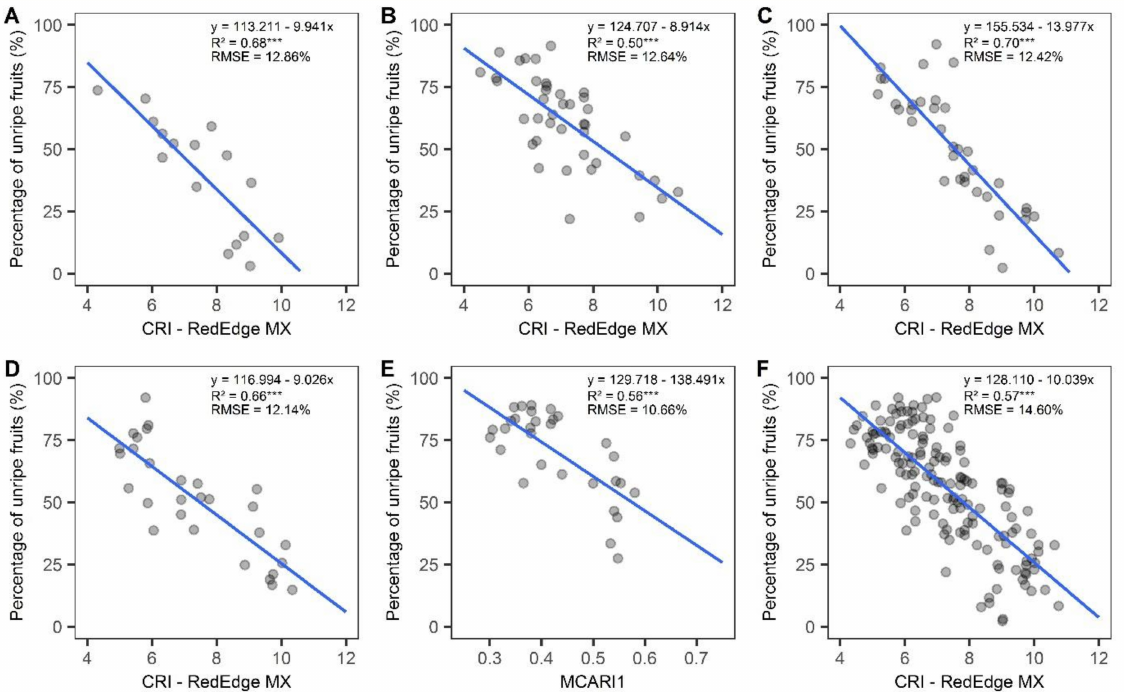
Figure 8. Best ranked models adjusted to the coffee ripeness using the vegetation indices. ( A ) Field A; ( B ) Field B; ( C ) Field C; ( D ) Field D; ( E ) Field E; ( F ) All coffee fields; CRI, Coffee ripeness index using the RedEdge MX camera; MCARI1, Modified Chlorophyll Absorption in Reflectance Index 1; R 2 values followed by *** are significant at 0.1 probability ( p <